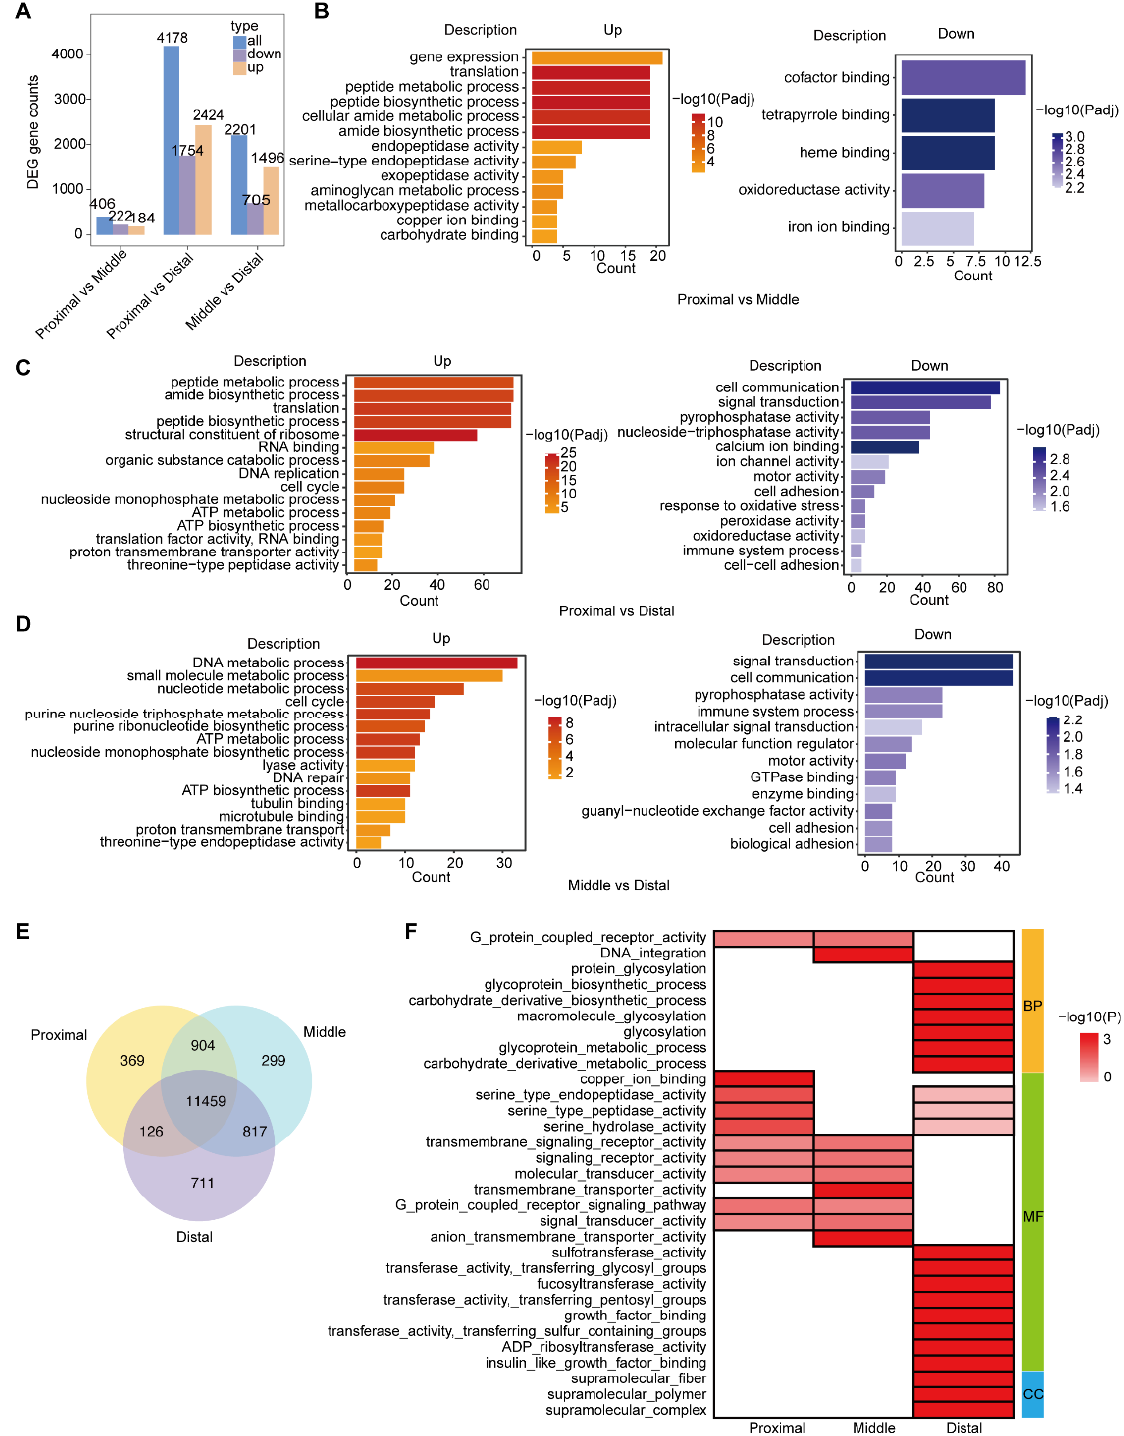
Figure 2. DEGs and specific genes enrichment analysis in different intestine segments. ( A ) The number of differential expression genes. ( B – D ) GO enrichment analyses for up-regulated genes and down-regulated genes. ( E ) Venn diagram of common and unique genes among the three segments. ( F ) Heat map diagram of GO enrichment of specific genes in the three segments. Color indicates − log(P), dark indicates high enrichment.